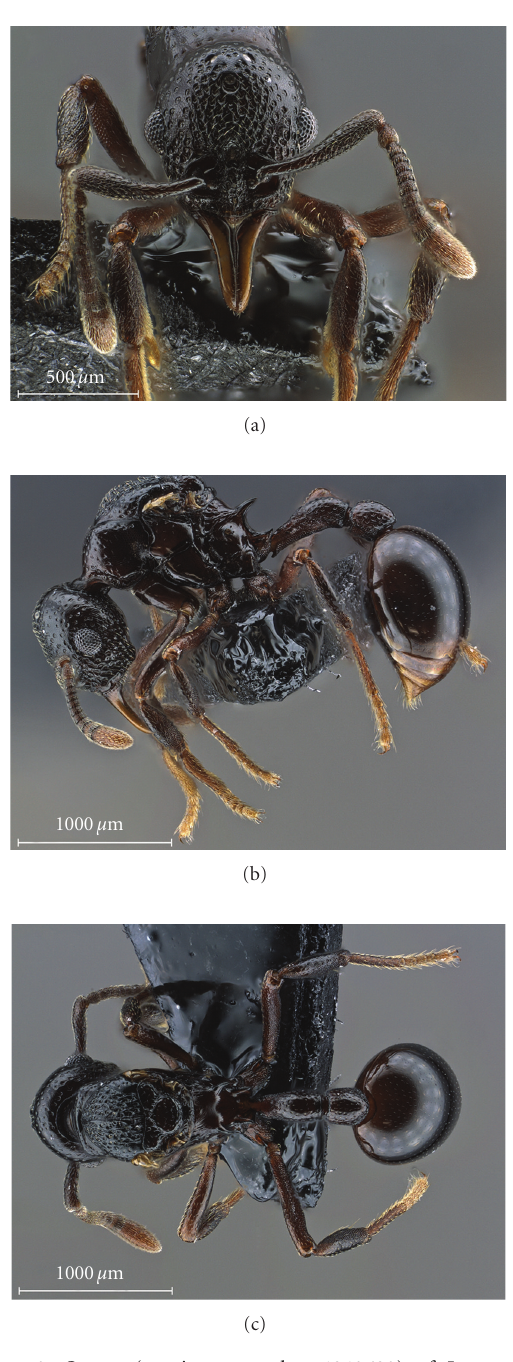
Figure 2: Queen (specimen number 4042602) of Lenomyrmex inusitatus Fern´andez 2001: in (a) frontal, (b) lateral, and (c) dorsal views. Note the predominantly smooth and shiny mesosoma, with mesoscutum foveolate-striate and without erect hairs (b, c) and the foveolate head, with median longitudinal striae